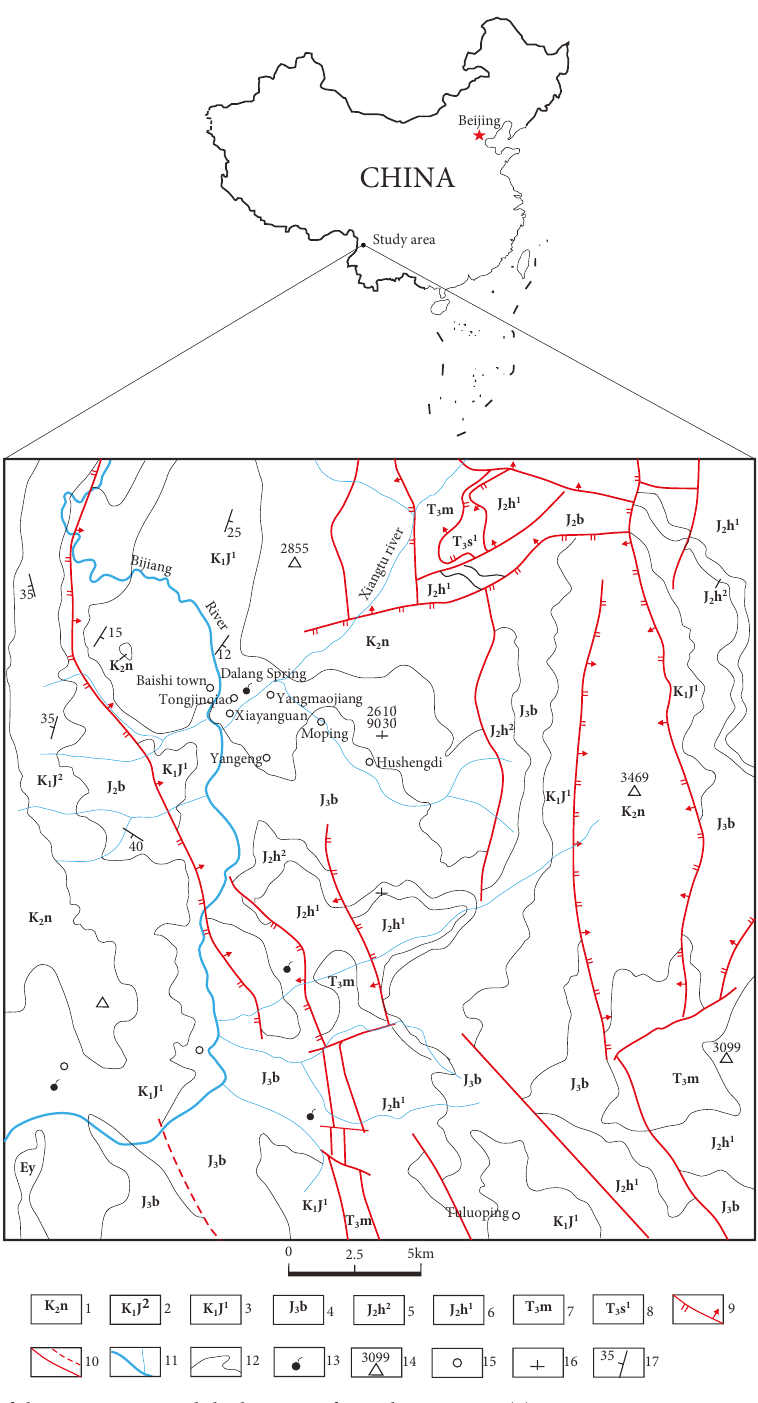
Figure 1: Geological map of the Bijiang area and the location of sampling springs. (1) Upper Cretaceous, Nanxin group, purple sandstone clipping conglomerate, and mud; (2) lower Cretaceous, Jingxing group, and purple mudstone; (3) lower Cretaceous, Jingxing group, white sandstone clipping purple, and gray mudstone; (4) upper Jurassic, Bazhulu group, purple mudstone, and siltstone; (5) middle Jurassic, Huakaizuo group, gray-green and purple mudstone, and marls; (6) middle Jurassic, Huakaizuo group, and purple sandstone clipping mudstone; (7) upper Triassic, Maichujing group, gray sandstone, and black shale clipping coal; (8) upper Triassic, Sanhedong group, limestone, and brecciated limestone; (9) main E-verging normal fault or W-verging normal fault; (10) fault; (11) Bijiang River; (12) stratigraphic limit; (13) hot spring; (14) mountain peak with its elevation (m); (15) town and county; (16) latitude and longitude coordinates; (17) attitude of the